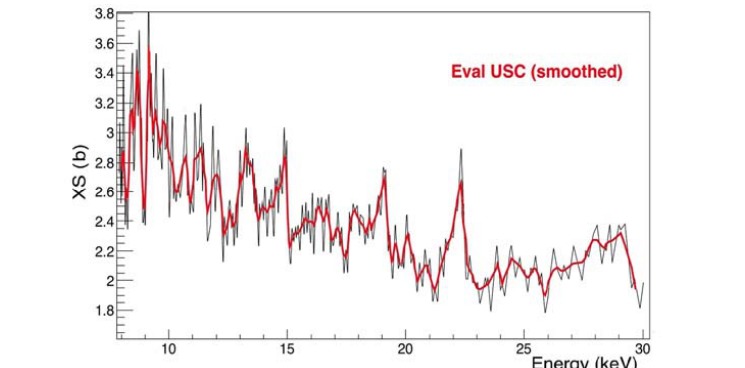
Fig. 5. Smoothed profile of the 235 U(n,f) cross section 3.2 Numerical results The numerical values of the USC-Eval data file are at the end, in Table 1. The uncertainty in energy is 0.1 % and in the cross section it can be estimated to be 2.6 %, assuming that the evaluated values are the mean of the experimental data with an energy binnig of 2000 bin